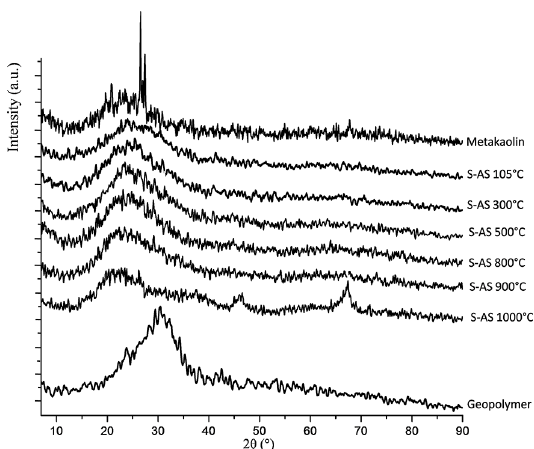
Figure 1. XRD pattern of the geopolymer, the synthetic powders at different heat treatment temperatures and